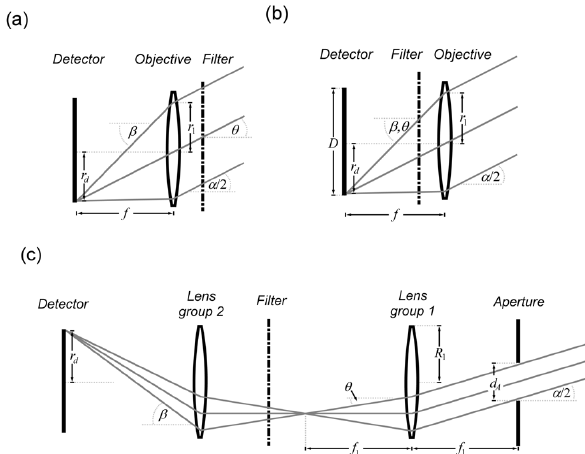
Fig. 7. Schematic of three different optical setups for SO 2 cameras. In (a) , the interference filter is placed in front of the object lens. In this case, the filter illumination angle θ is a function of the viewing Figure 7. Schematic of three different optical setups for SO 2 cameras. In (a), the interference 5 direction and is largest close to the edge of the image. In (b) , the filter is placed in front of the object lens. In this case, the filter illumination angle θ is a 6 filter is positioned behind the objective. Here, a range of different Figure 7. Schematic of three different optical setups for SO 2 cameras. In (a), the interference 5 Figure 7. Schematic of three different optical setups for SO 2 cameras. In (a), the interference 5 function of the viewing direction and is largest close to the edge of the image. In (b), the filter 7 angles θ are obtained for each detector pixel. Inset (c) shows a setup filter is placed in front of the object lens. In this case, the filter illumination angle θ is a 6 is positioned behind the objective. Here, a range of different angles θ are obtained for each 8 filter is placed in front of the object lens. In this case, the filter illumination angle θ is a 6 designed to minimize θ . In linear approximation, the maximum function of the viewing direction and is largest close to the edge of the image. In (b), the filter 7 detector pixel. Inset (c) shows a setup designed to minimize θ . In linear approximation, the 9 function of the viewing direction and is largest close to the edge of the image. In (b), the filter 7 illumination angle is proportional to the ratio of the aperture size is positioned behind the objective. Here, a range of different angles θ are obtained for each 8 maximum illumination angle is proportional to the ratio of the aperture size d A to the focal 10 is positioned behind the objective. Here, a range of different angles θ are obtained for each 8 d A to the focal length f 1 of lens group 1 in this detector pixel. Inset (c) shows a setup designed to minimize θ . In linear approximation, the 9 length f 1 of lens group 1 in this setup. 11 detector pixel. Inset (c) shows a setup designed to minimize θ . In linear approximation, the 9 maximum illumination angle is proportional to the ratio of the aperture size d A to the focal 10 maximum illumination angle is proportional to the ratio of the aperture size d A to the focal 10 length f 1 of lens group 1 in this setup. 11 length f 1 of lens group 1 in this setup. 11